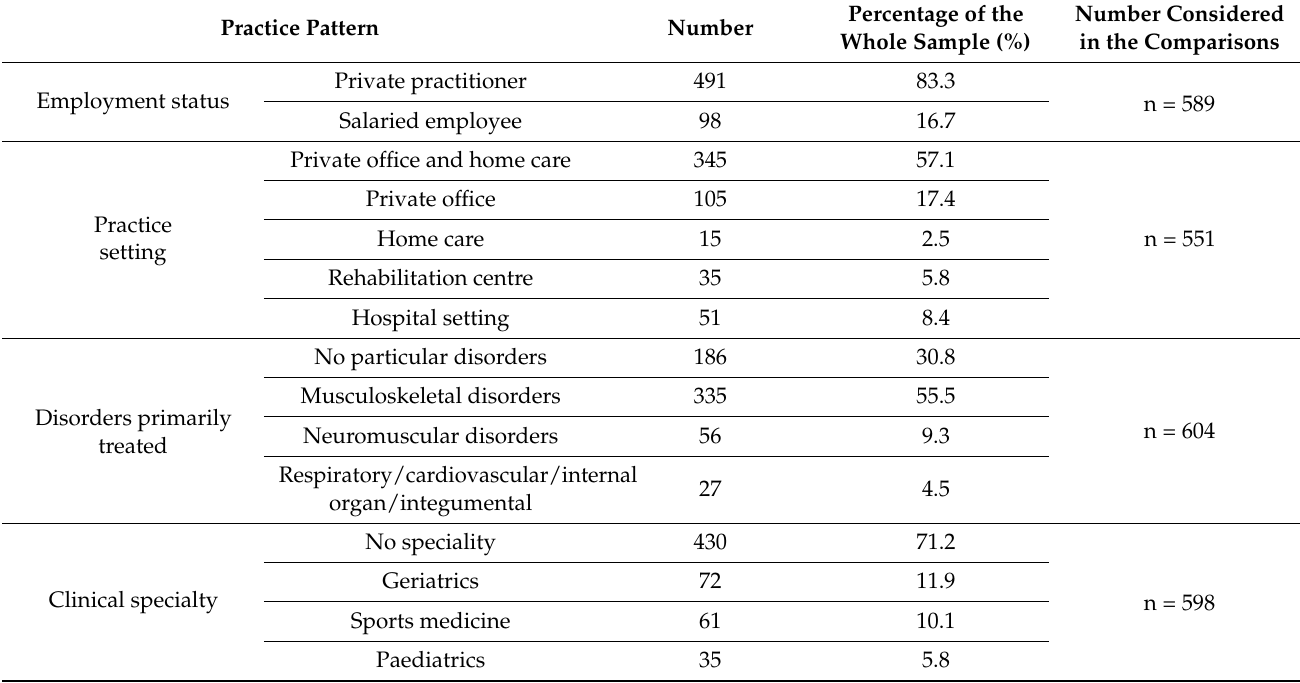
Table 1. Distribution of the participating physiotherapists, as a function of practice pattern.